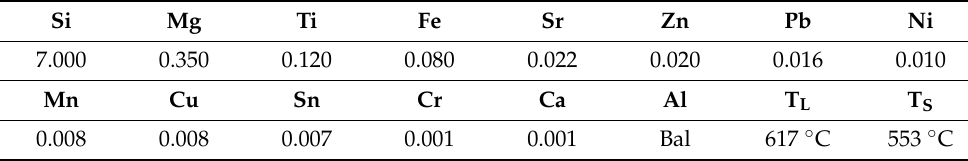
Figure 2. Solid fraction vs. temperature for A356. Table 1. Chemical compositions (wt %) and thermal characteristics of A356.